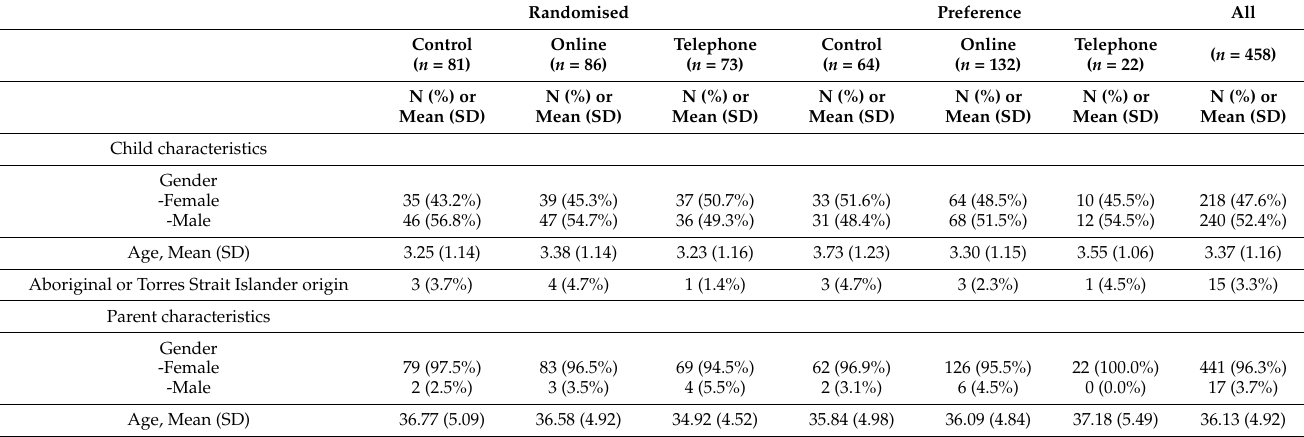
Table 1. Baseline demographic characteristics of Time for Healthy Habits participants by study arm and